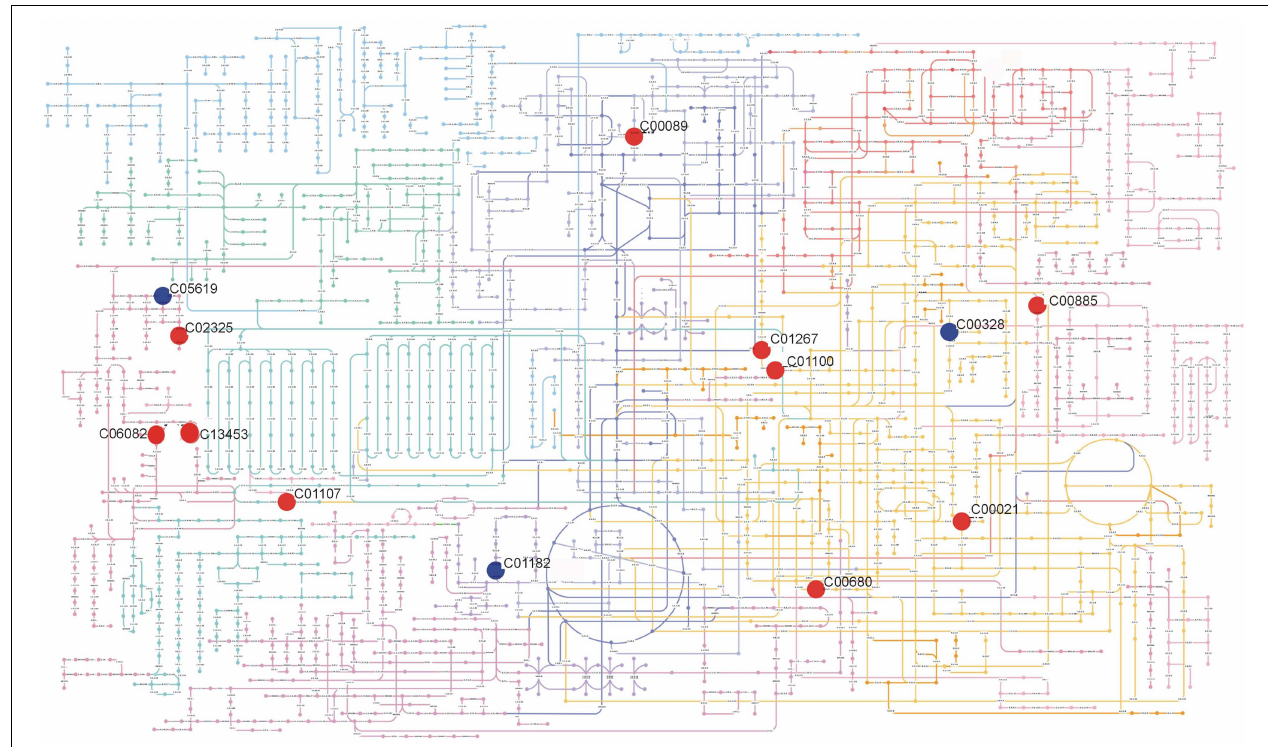
2-Amino-4-({[5-(6-amino-9H-purin-9-yl)-3,4-dihydroxytetrahydro-2- furanyl]methyl}sulfanyl)butanoic acid (C00021); Isochorismate (C00885); L-Kynurenine (C00328); D-Ribulose 1,5-bisphosphate (C01182); 5-Hydroxyferulic acid (C05619). Positioning of metabolites on the metabolic map was made using Pathway Projector ( Kono et al., 2009). Red circles indicate metabolites that were significantly ( p ≤ 0 . 01 ) more abundant in Ws-3, while blue circles indicate metabolites that were significantly ( p ≤ 0 . 01 ) less abundant in Ws-3.